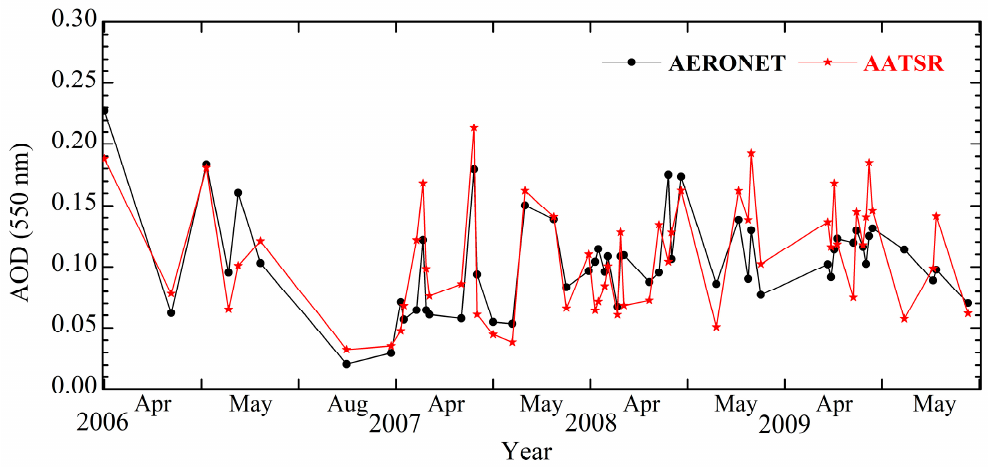
Figure 4. Time series of AATSR derived AOD at 550 nm compared to AERONET AOD.